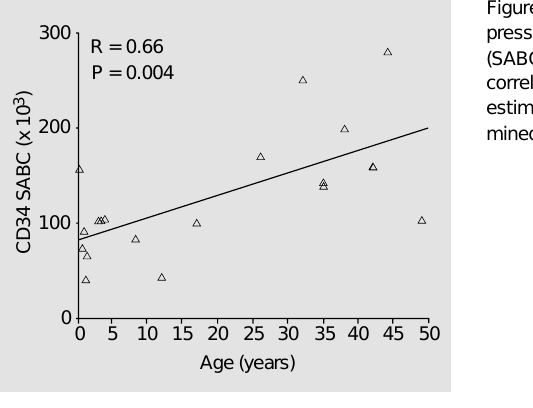
3 - Linear regression analysis of the CD34 ex- pression (reported as specific antibody binding capacity (SABC) values in arbitrary units (a.u.)) against age. The correlation coefficient R = 0.66, standard error of the estimate = 50.5 x 10 3 a.u. and the P value were deter- mined by the Spearman rank correlation